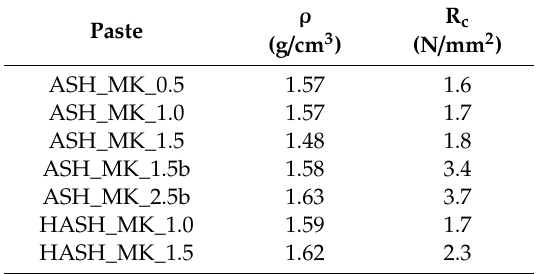
Table 5. Hardened density ( ρ ) and compressive strength (R c ) of one-part alkali-activated mortars. ρ R c Paste (g / cm 3